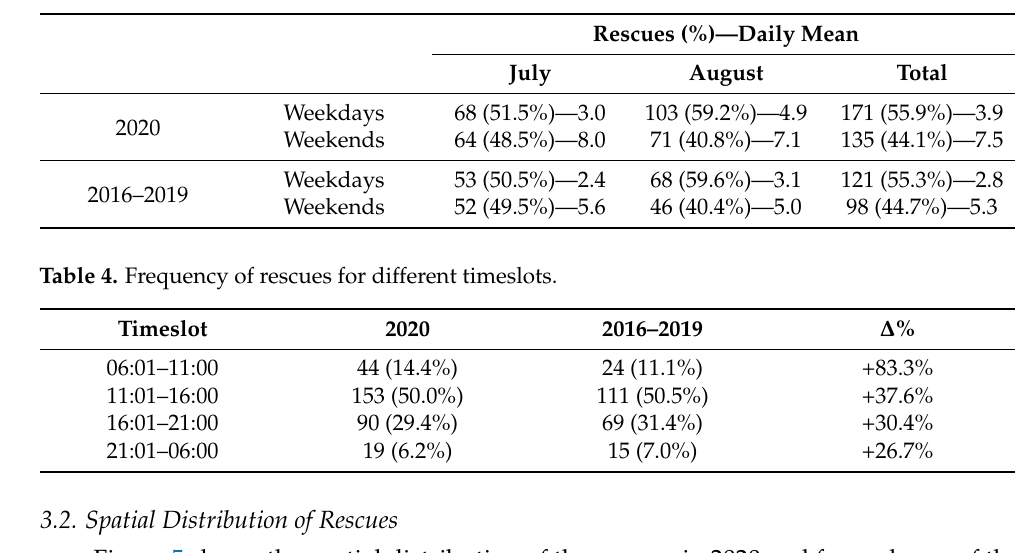
Table 4. Frequency of rescues for different timeslots.